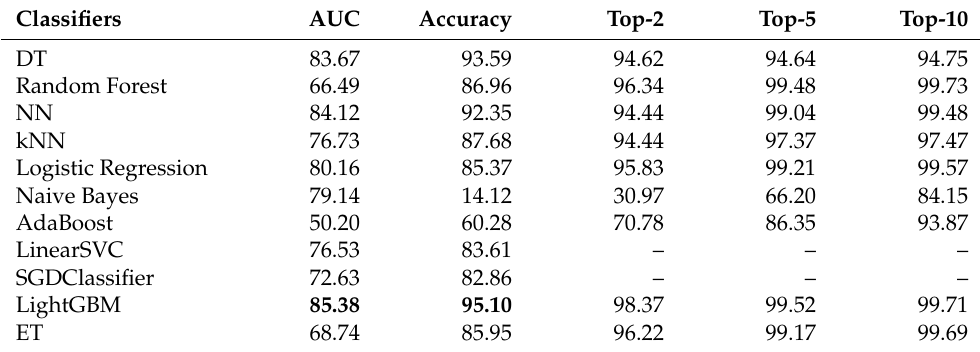
Table 3. Results with the GridSearchCV parameters analysis. Bold highlights best